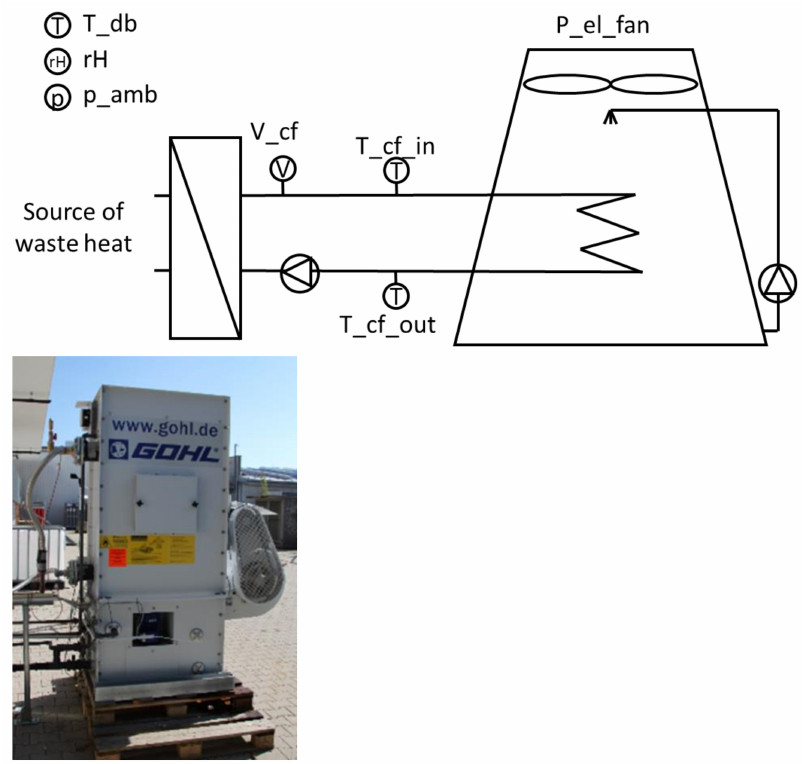
Figure 1. Simplified scheme of the cooling tower test setup including sensor positions; ambient air conditions were measured next to the cooling tower.